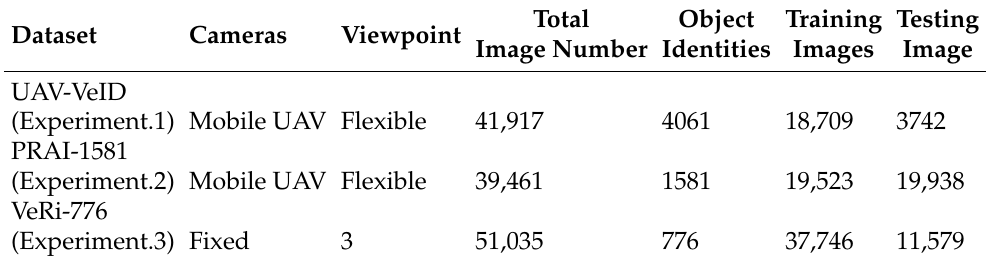
Table 1. Detailed setting comparisons between different experimental datasets.